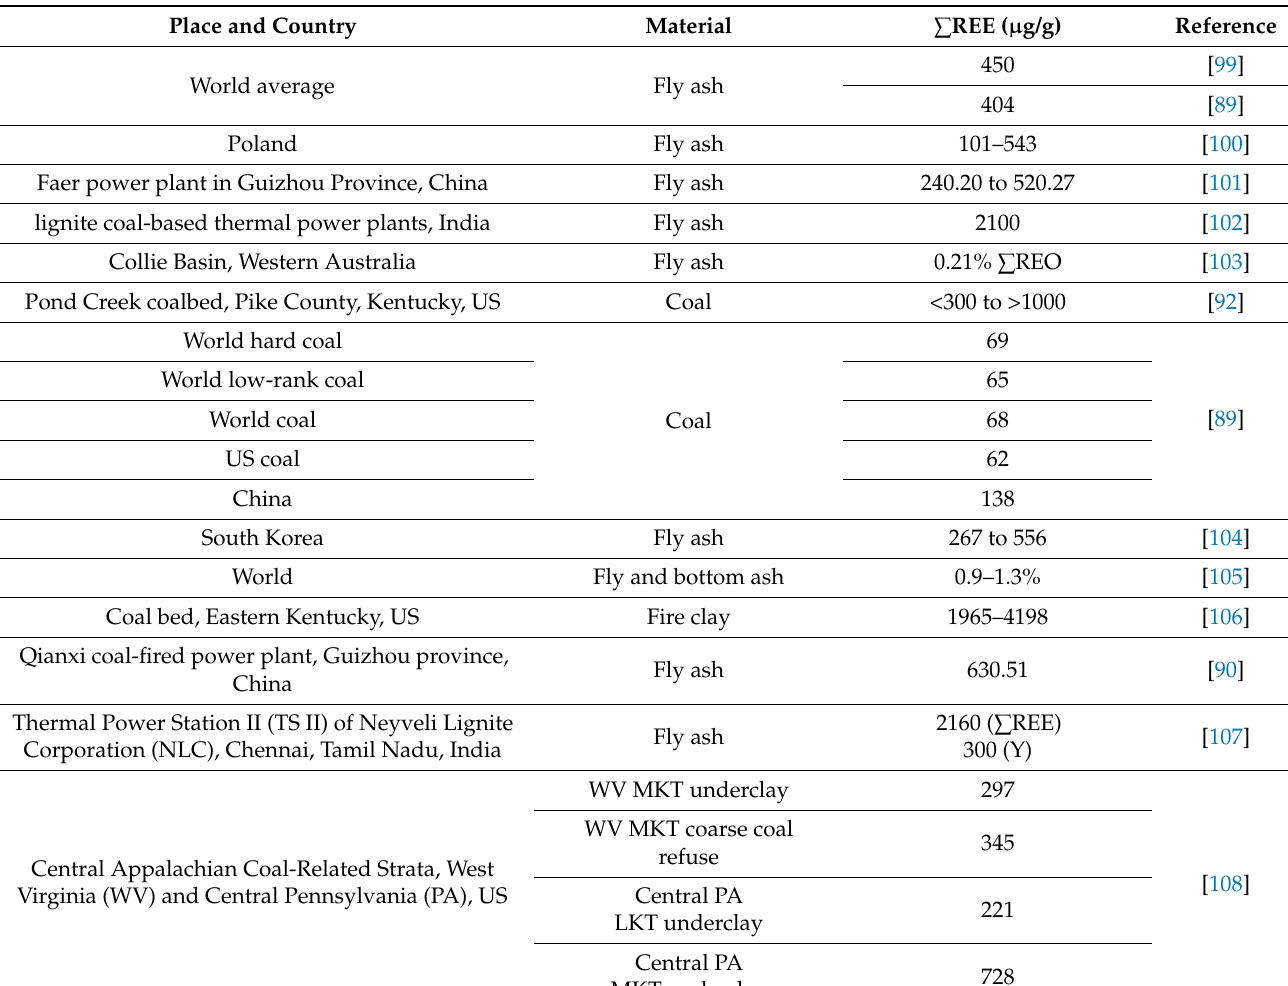
Table 4. Concentrations of rare earth elements in coal, coal fly ash, and underclay from different sources around the